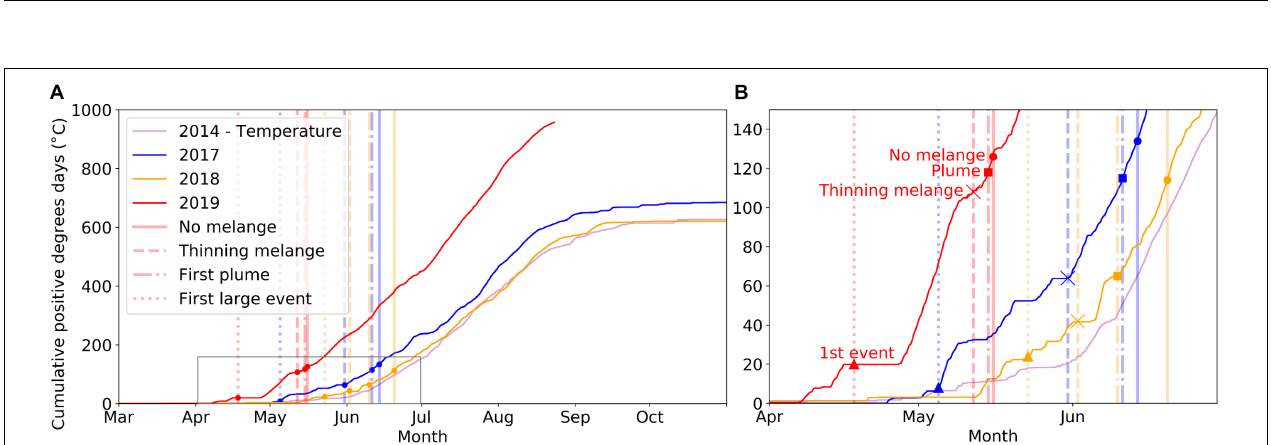
FIGURE 14 | Cumulative (A) volume and (B) number of calving events per day along the front. The cumulative number of events per day are separated in smaller events with less than 60,000 m 3 (solid lines) and large ones above 60,000 m 3 (dotted lines). Data from field campaigns later in the melt season (which typically have higher calving activity) are indicated by thick lines.